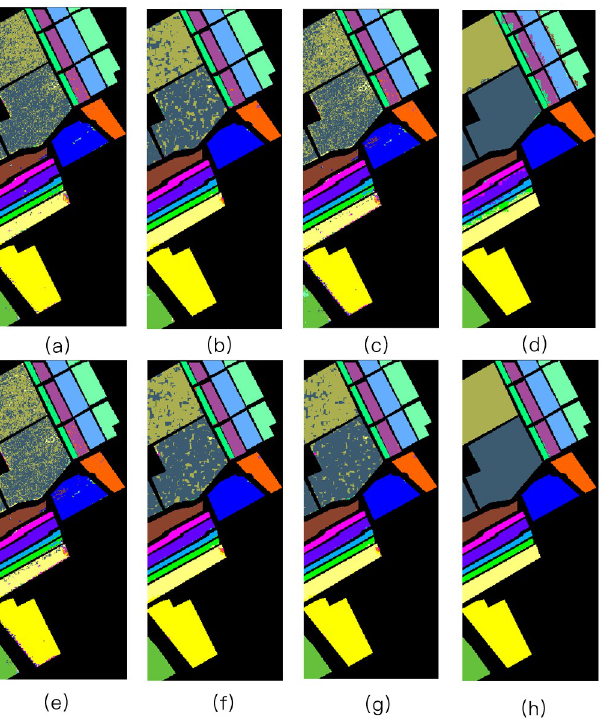
Fig 6. The Salinas image. (a) SVM [1] (OA = 88.67%); (b) JSR [17] (OA = 92.99%); (c) SR [16] (OA = 85.09); (d) MASR [19] (OA = 93.43%); (e) NN-SR [18] (OA = 85.37%); (f) JNN-JSR [27] (OA = 94.46%); (g) WJNN-JSR [27] (OA = 95.61%); (h) WLSC-SR (OA = 99.71%).